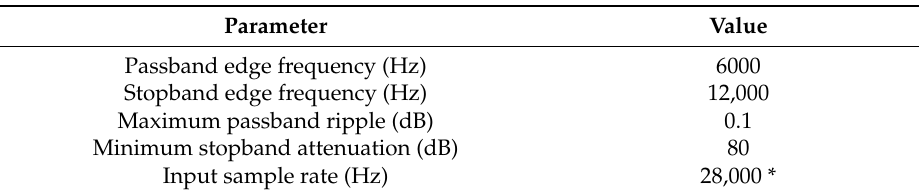
Figure 3. Low pass filter block characteristics. Table 1. Parameters of low pass filter